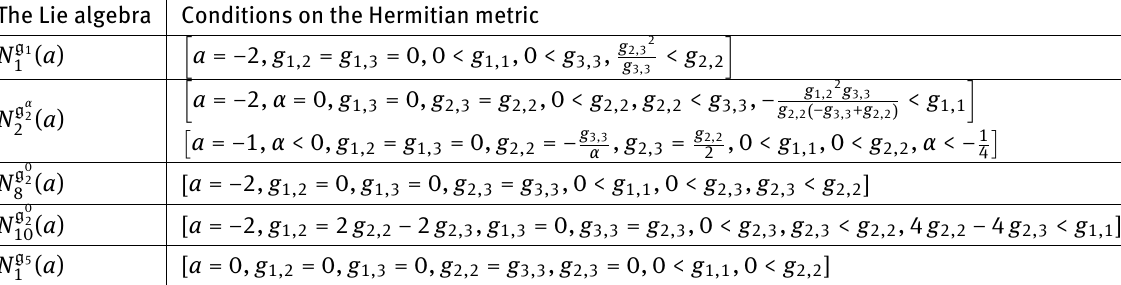
Table 3: Examples of Kähler Lie algebras.